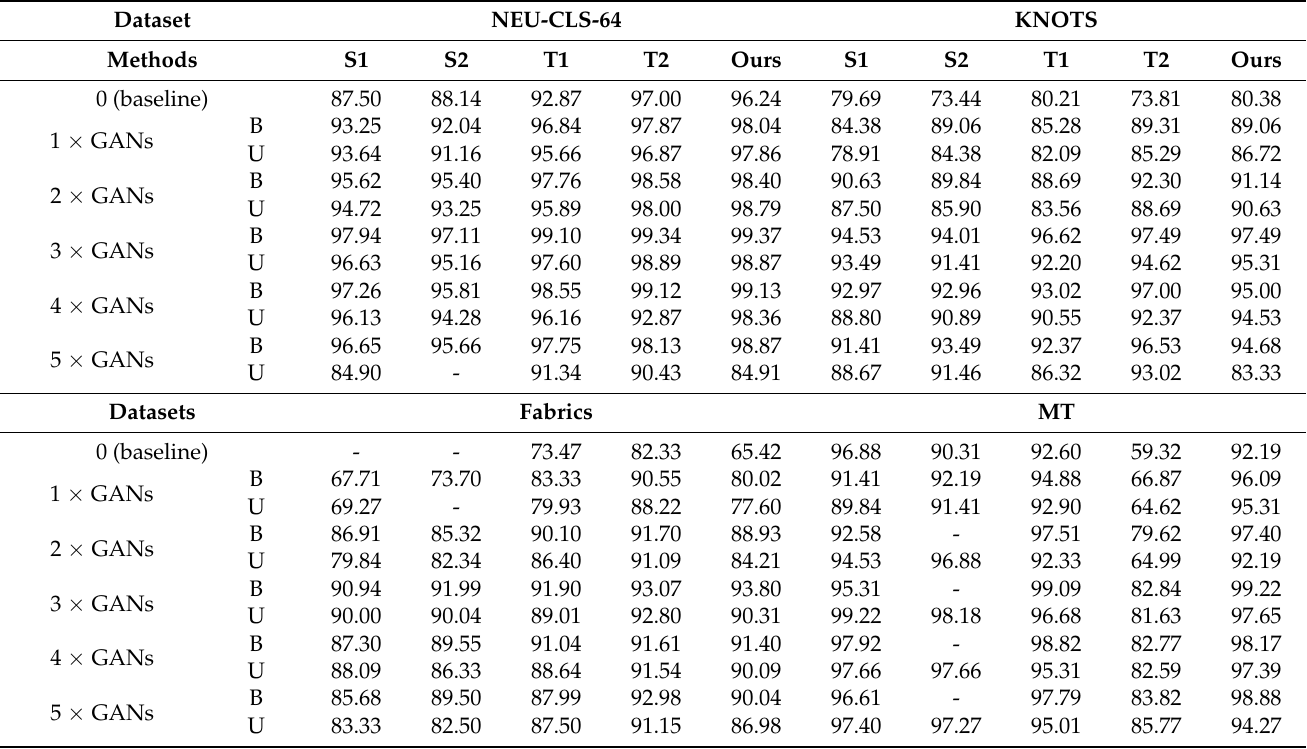
Table 4. Comparison with other defect classifiers on four defect